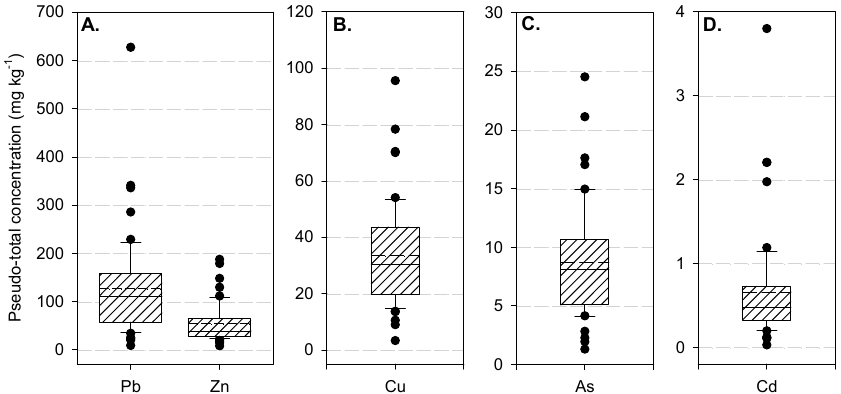
Figure 4. The mean and range of trace element pseudo-total concentrations in a subset of surveyed urban soils ( n = 52). The dashed line is the mean value, the solid line is the median, the box represents the upper and lower quartiles, and the whiskers are the 10th and 90th percentiles.